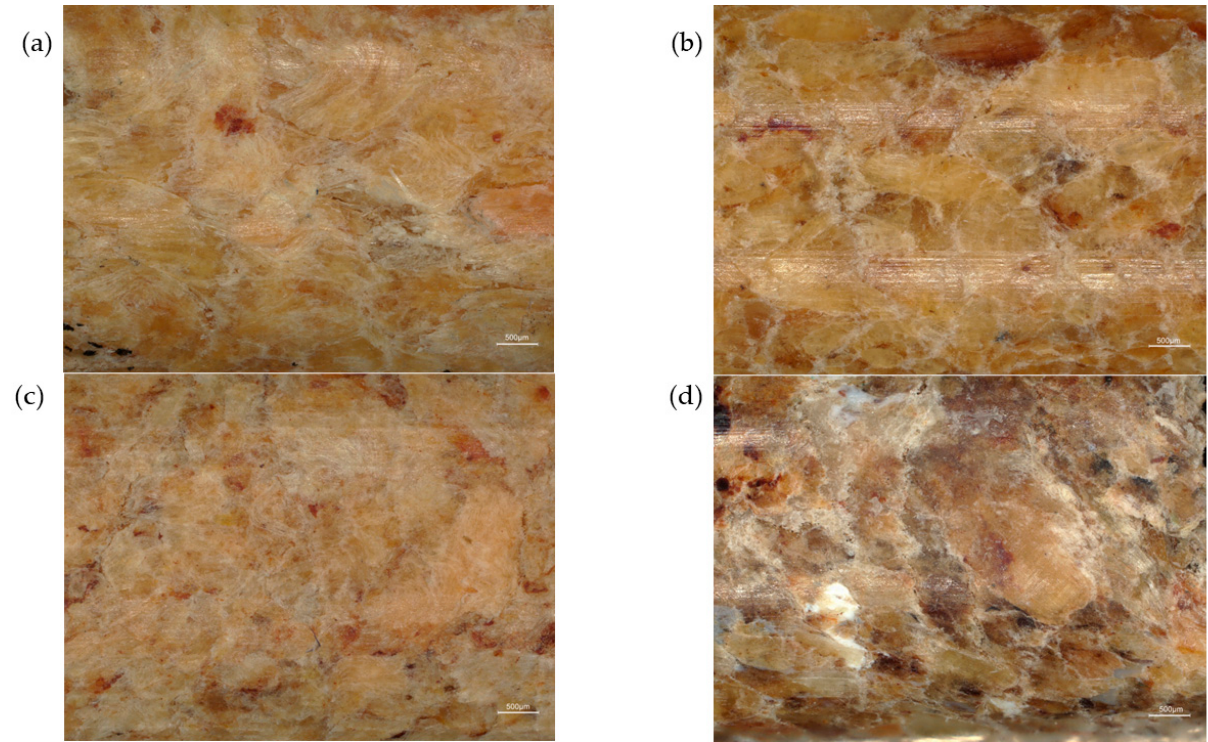
Figure 3. Surface area of tested wood pellets ( a ) P1, ( b ) P2, ( c ) P3, and ( d ) P4.